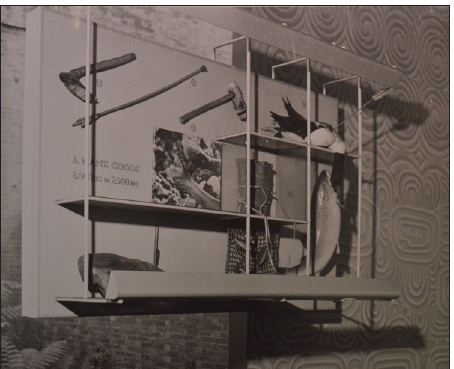
Figure 3: ‘A Man’s Goods 8000BC to 2500BC’ display in the People of Britain Pavilion at the Festival of Britain’s South Bank Exhibi- tion in 1951. The display was one of sev- eral portraying different material culture through British history including hunting implements like these. Reproduced with permission: © The National Archives, ref. WORK25/216